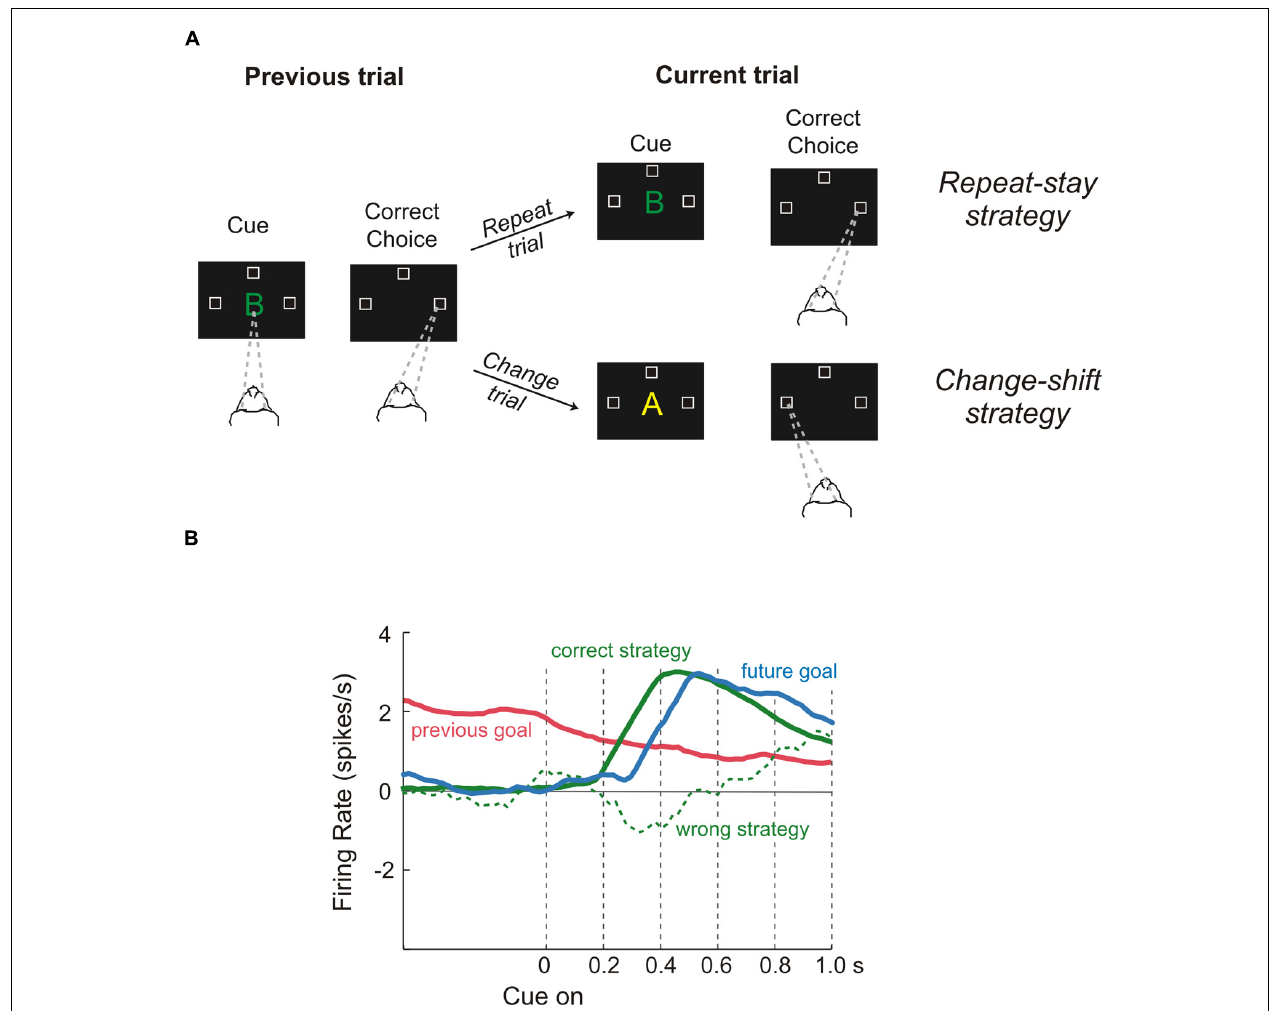
response (repeat trial), while if the cue was different they had to change their response (change trial).Thus, monkeys were forced to change strategy according to the past trial history, adopting either a repeat-stay strategy or a change-shift strategy (B) Neural activity reflecting the previous goal (red), the future goal (blue), the correct strategy (solid green line), and the wrong strategy (dashed green line). Previous-goal signal decreased after cue onset as the signals for the correct strategy and future goal increased. In contrast, when monkeys chose the wrong strategy, a weak or absent strategy signal occurred during the time of goal selection. Reproduced with permission from Wise